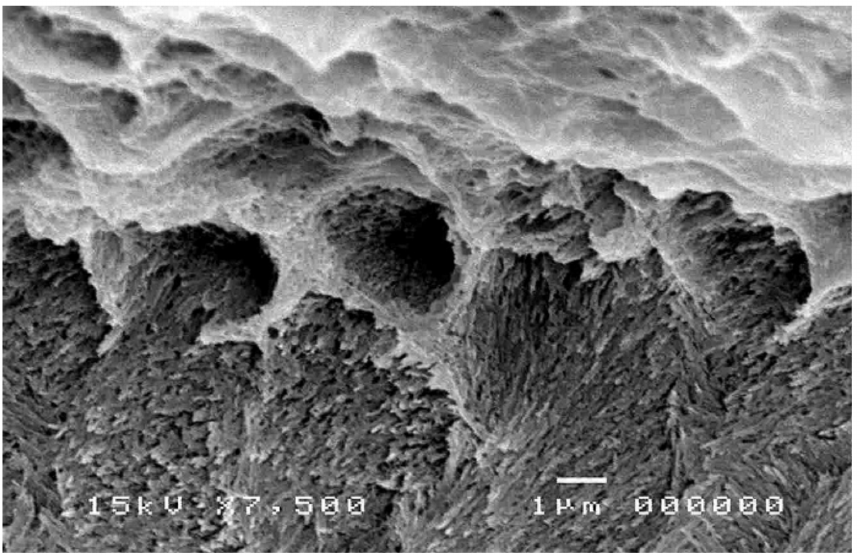
Figure 7. An SEM micrograph of fractured experimental biopolymer bonded with Super-Bond specimen after chemical challenge demonstrating the honeycomb-like pattern at the interfacial area (original 7500 ×